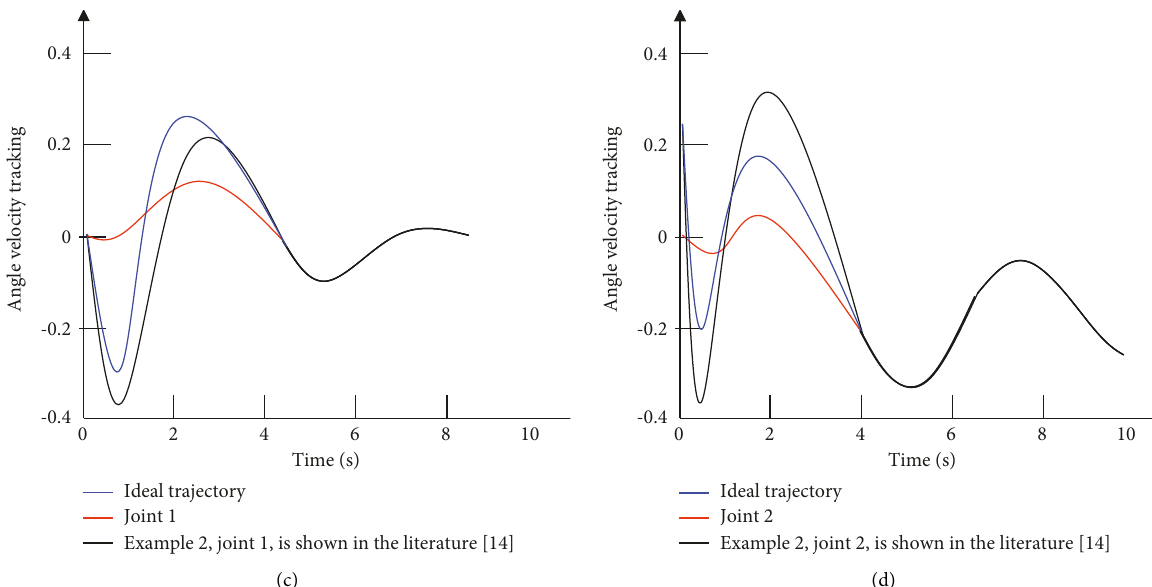
Figure 7: Simulation curve of angular displacement and angular velocity of double-joint manipulator. (a) Joint 1 angle tracking, (b) Joint 2 angle tracking, (c) Joint 1-angular velocity tracking, (d) Joint 2-angular velocity